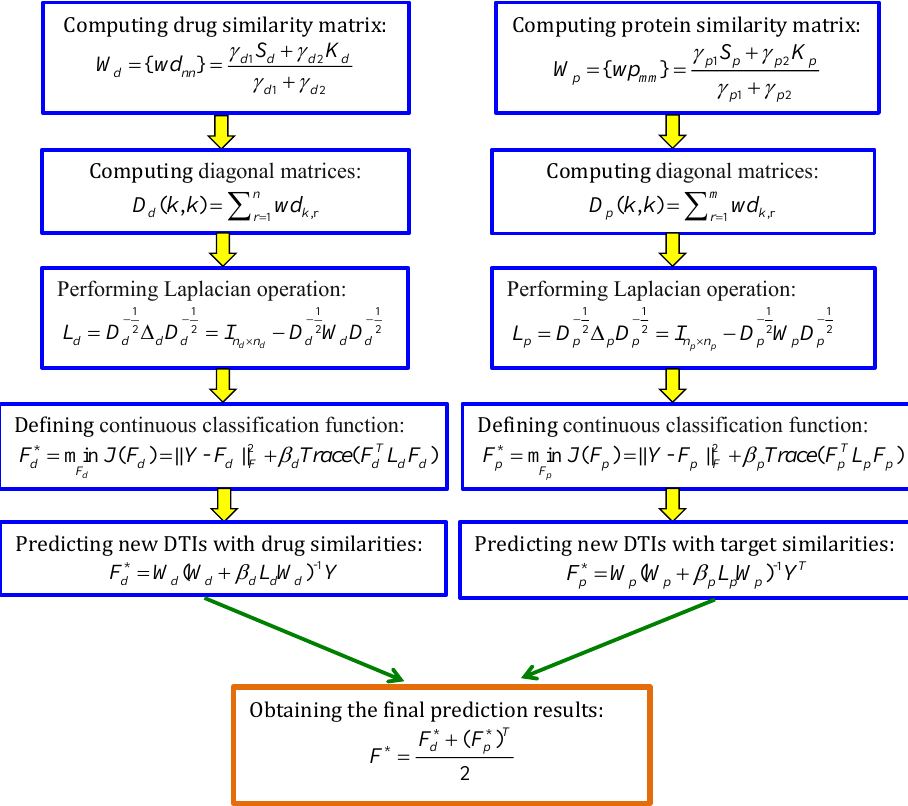
Figure 7. The flowchart of Laplacian regularized least square (LapRLS) incorporating DTI network